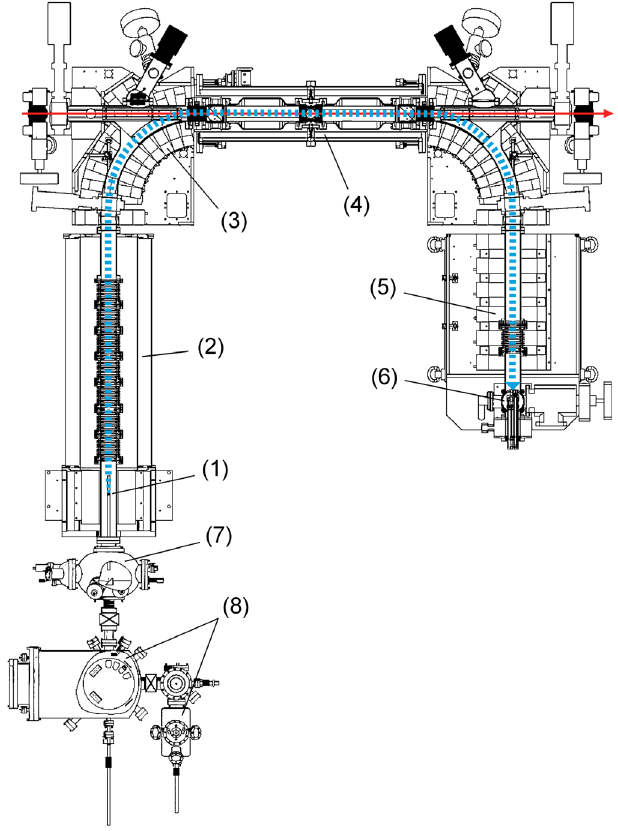
FIG. 2. Overview of the Electron Target (2 in Fig. 1). The electron beam (blue dashed line) was emitted from a cold GaAs: (Cs,O) photocathode (1) embedded in a strong axial magnetic field. Magnetic expansion of the beam took place at the entrance of the adiabatic acceleration section (2). For low ion velocities, as discussed here, the latter was not used, as electrons reached their final energy already in the electron gun. A toroidal coil (3) merged the electrons with the ion beam (solid red line). After a 1.5-m- long interaction section (4) the beams were separated by another toroid. After deceleration (5), the electrons were dumped into a Faraday cup (6). The GaAs:(Cs,O) emitter was illuminated in transmission mode by an 808-nm laser from the photocathode setup (7). The latter contains facilities for in-vacuum cleaning and reactivation of cathodes (8), allowing quasicontinuous